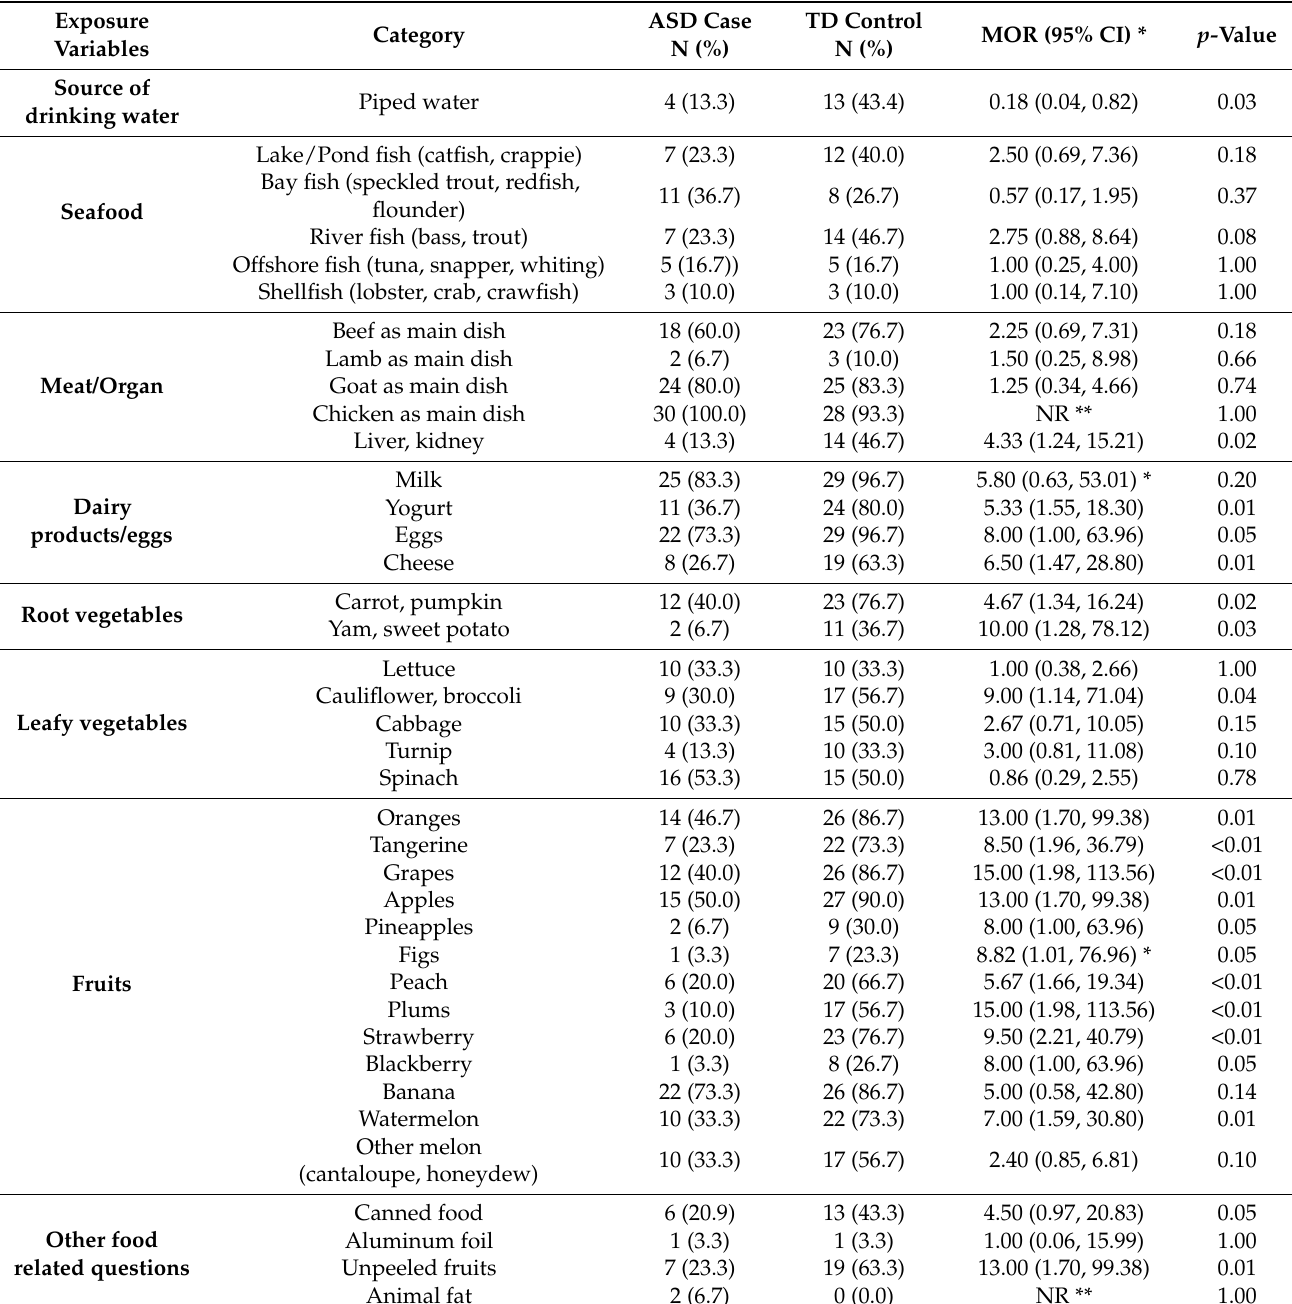
Table 2. Comparison of dietary factors between ASD case and TD controls using Conditional Logistic Regression (CLR) based on 60 children (30 matched